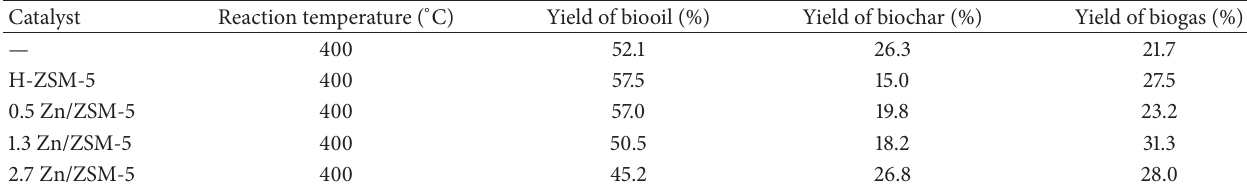
Table 1: The yield of biooil, biogas, and biochar obtained from cellulose pyrolysis at 400 ∘ C. Catalyst